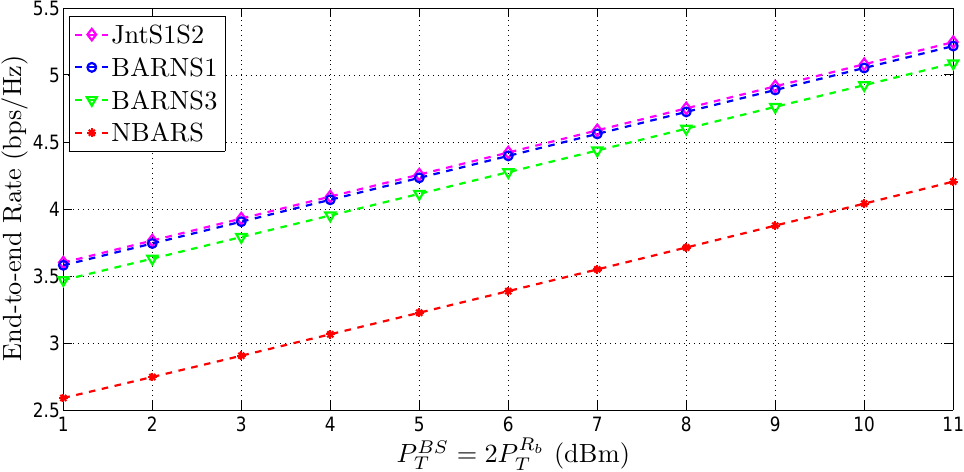
Figure 3. Throughput (bps/Hz) versus total power budget (power at the relay is half of the source node’s available power.